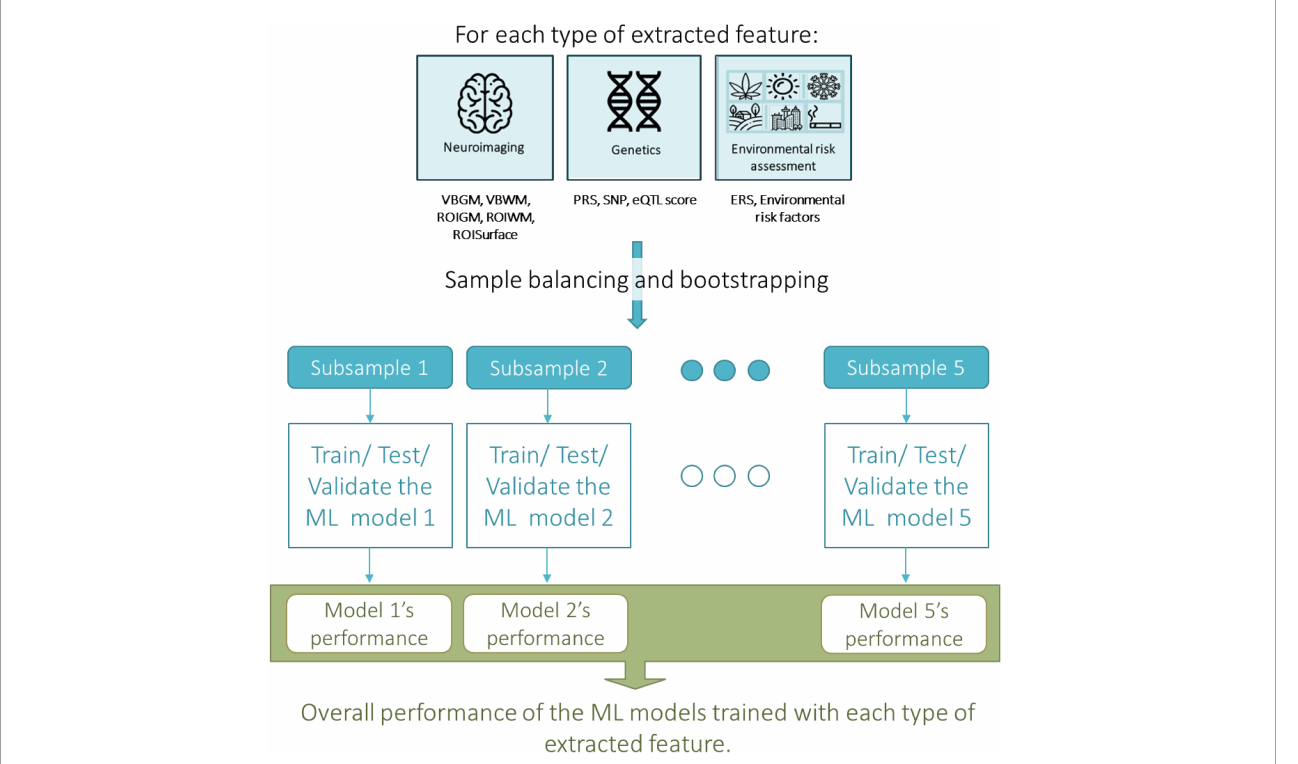
FIGURE1 Overall machine learning approach taken for assessing the predictive value, i.e., the accuracy, of each type of extracted neuroimaging, genetic or environmental feature in predicting transition to psychosis from an At Risk Mental State (ARMS). ERS, environmental risk score; eQTL score, expression quantitative trait loci; PRS, polygenic risk score; ROIGM, regional-based gray matter volumes; ROISurface, surface-based regional cortical thickness, and gyrification, sulci, and complexity indexes; ROIWM, regional-based white matter volumes; SNP, single nucleotide polymorphism; VMGM, voxel-based gray matter volume maps; VMWM, voxel-based white matter volume